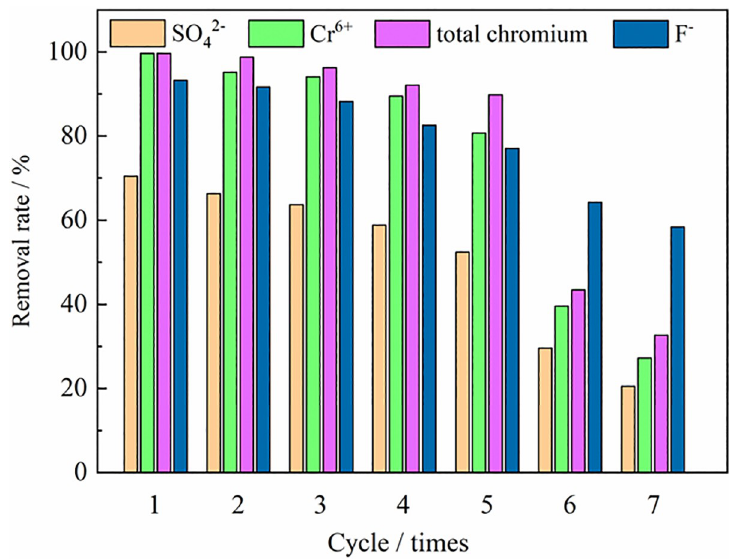
Fig 16. Stability and reusability of ZPC particles for up to 7